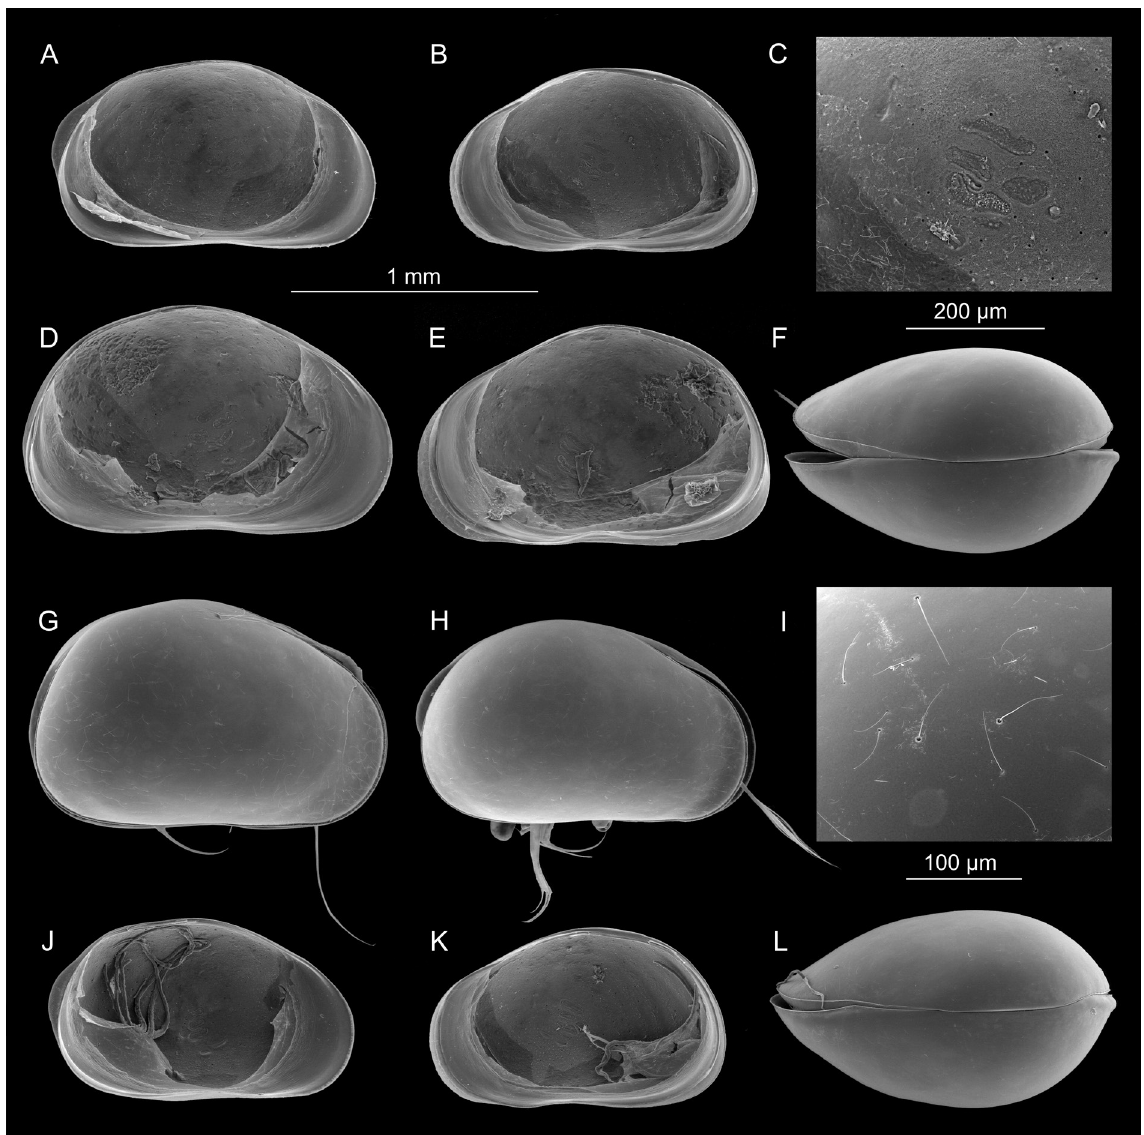
Fig. 12. Billcypris davisae gen. et sp. nov. A–I, L. Lake Cowan (type locality, sample OSTR064B). J, K. Lake Lefroy (sample OSTR063A). A . LVi, ♂, holotype (WAM 67217). B . RVi, ♂, holotype (WAM 67217). C . RVi, detail of central muscle scars, ♂, holotype (WAM 67217). D . LVi, ♀, allotype (WAM 67218). E . RVi, ♀, allotype (WAM 67218). F . CpD, ♂ (WAM 67222). G . CpRL, ♀ (WAM 67219). H . CpRL, ♂ (WAM 67221). I . CpRL, detail of external surface, ♀ (WAM 67219). J . LVi, ♂ (WAM 67224). K . RVi, ♂ (WAM 67224). L . CpD, ♀ (WAM 67220). Scales: A–B, D–H, J–L = 1 mm; C = 200 µm; I = 100